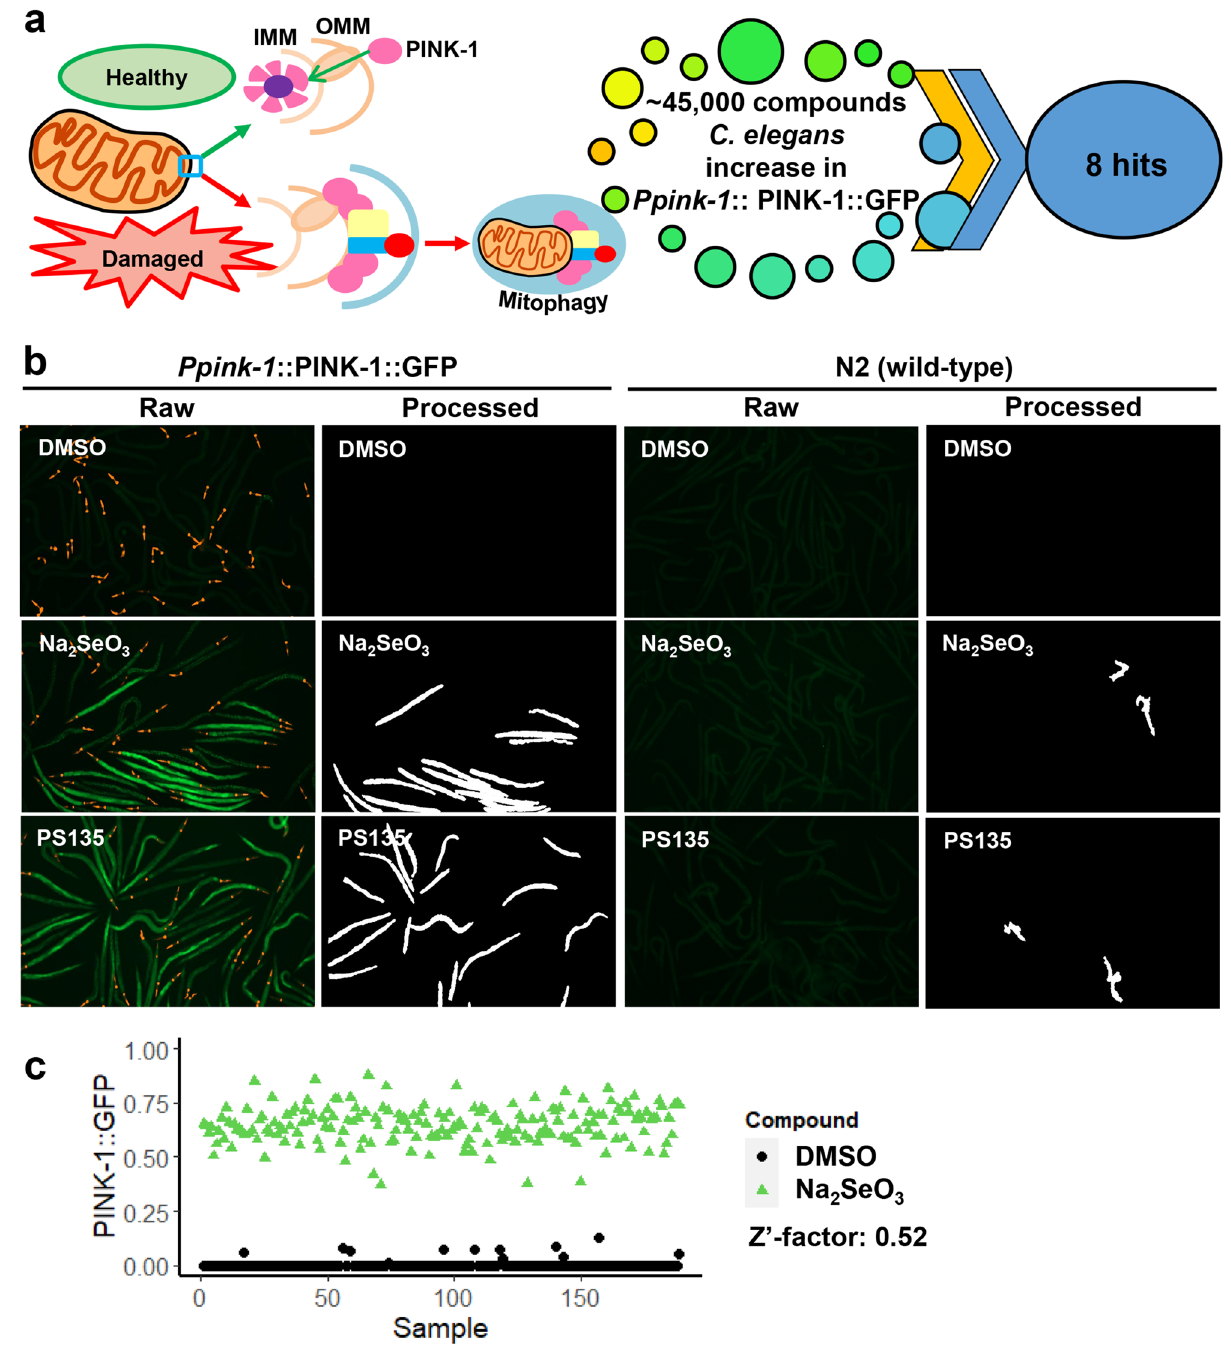
Figure 1. A high-throughput, high-content PINK-1/PINK1 stabilization screen yielded eight hit compounds. ( a ) The accumulation of PINK-1/PINK1 in the outer mitochondrial membrane of damaged mitochondria initiates mitophagy. 45,000 compounds were screened in C. elegans resulting in eight PINK-1/PINK1 stabilizers. ( b ) Fluorescent (raw) and cell profiler-processed (processed) images of C. elegans carrying Ppink-1 ::PINK-1/ PINK1::GFP or N2 wild-type after 24 h of treatment with Na 2 SeO 3 , PS135, or DMSO control. Representative images are shown. ( c ) Quantification of GFP fluorescence of C. elegans carrying Ppink-1 ::PINK-1/PINK1::GFP after 72 h treatment with 7 mM Na 2 SeO 3 or DMSO control. Three biological replicates for ( b , c ) were performed and